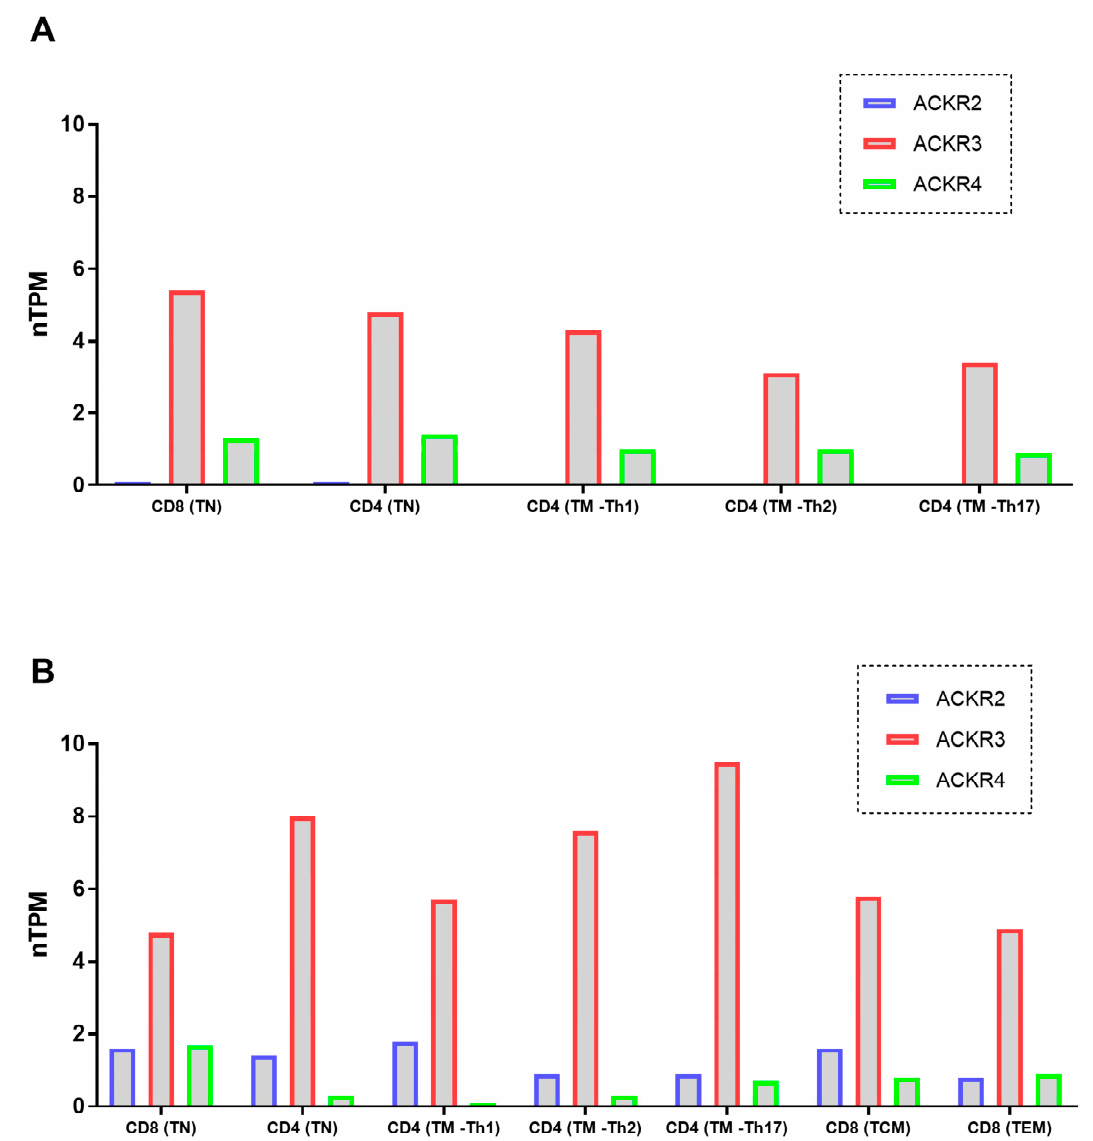
Figure 5. ACKR2, ACKR3 and ACKR4 mRNA expression on T lymphocytes populations according to public databases ( A ) Schmiedel datasets and ( B ) Monaco datasets. Legend: TN — Naive T cell; TM — Memory T cell;